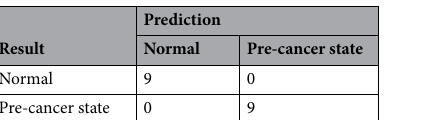
Table 1. Discrimination between normal and precancerous states using comprehensive genetic